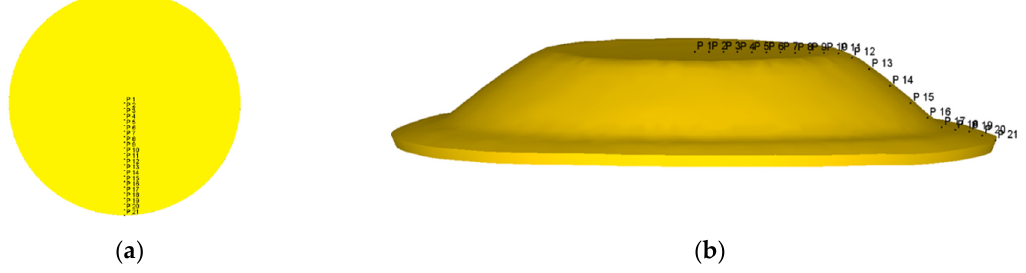
Figure 3. The location of material flow law analysis points: ( a ) Before part forming; ( b ) after part forming.